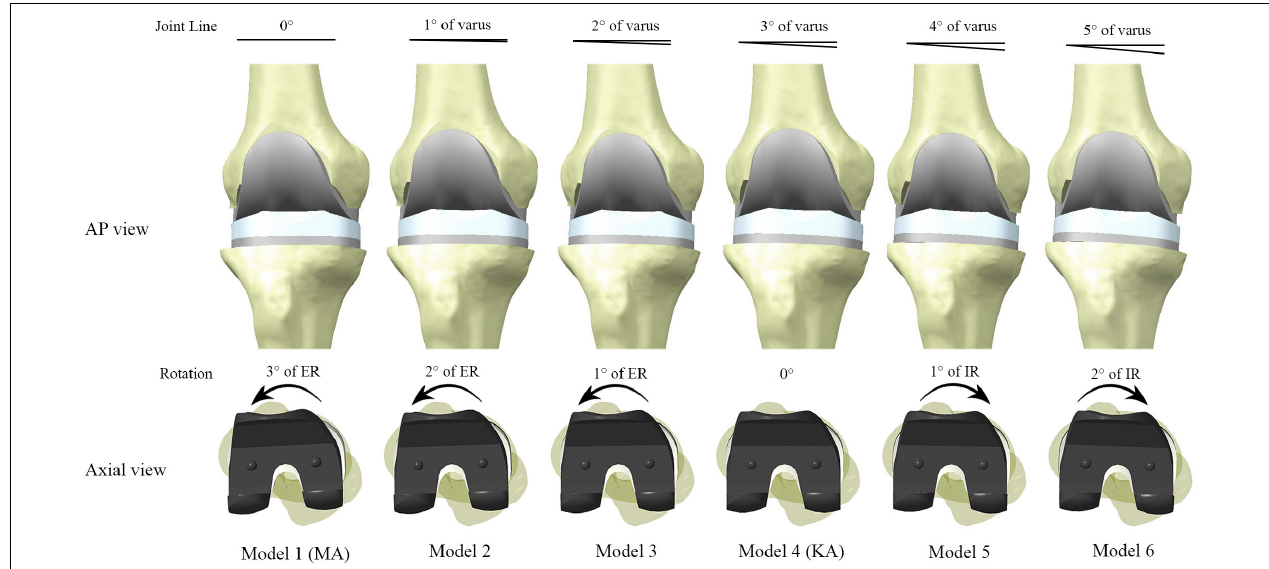
FIGURE 4 | Models constructed in this study with different joint alignment. The joint line inclination and internal rotation of the implants were increased in 1 ◦ increments between models, up to Model 6 (5 ◦ varus of joint line, 2 ◦ internal rotation of implant). Model 4 reproduced the original tibiofemoral articular geometry of the “standard” patient, and therefore met the technical requirements of kinematic alignment (KA). ER and IR represent internal rotation and external rotation relative to the posterior condylar axis, respectively.